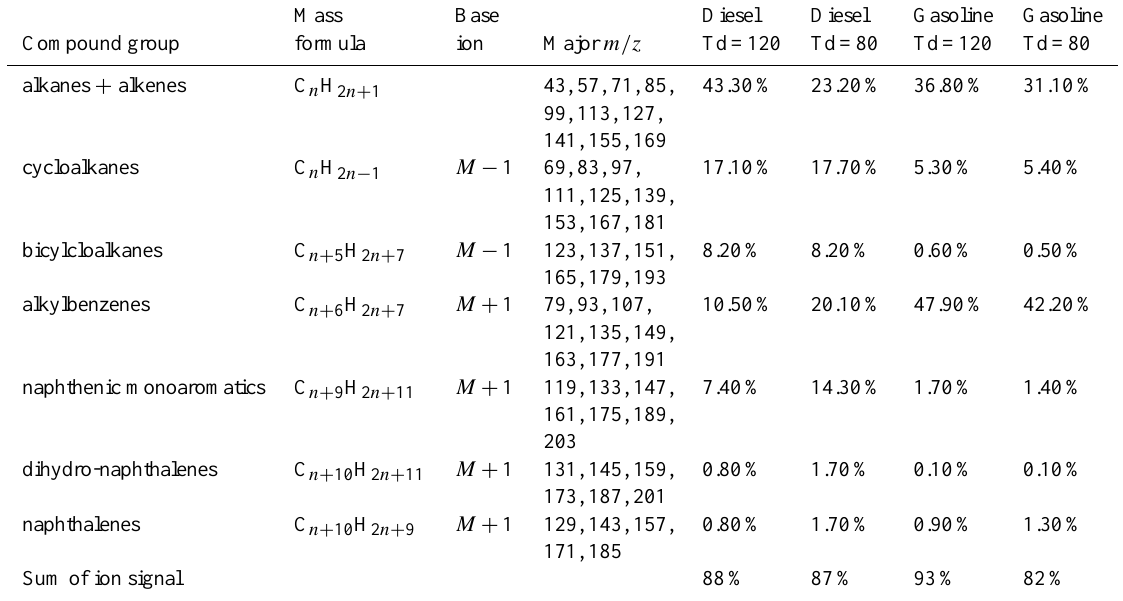
Table 1. Percent of total ion signal for the different groups in diesel and gasoline fuels. Mass Base Diesel Diesel Gasoline Gasoline Compound group formula ion Major m/z Td=120 Td=80 Td=120 Td=80 alkanes +